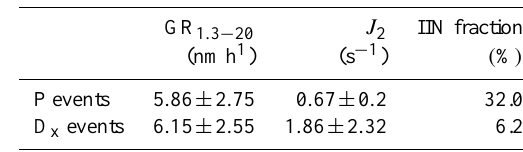
Table 4. Comparison of nucleation characteristics between D x and P